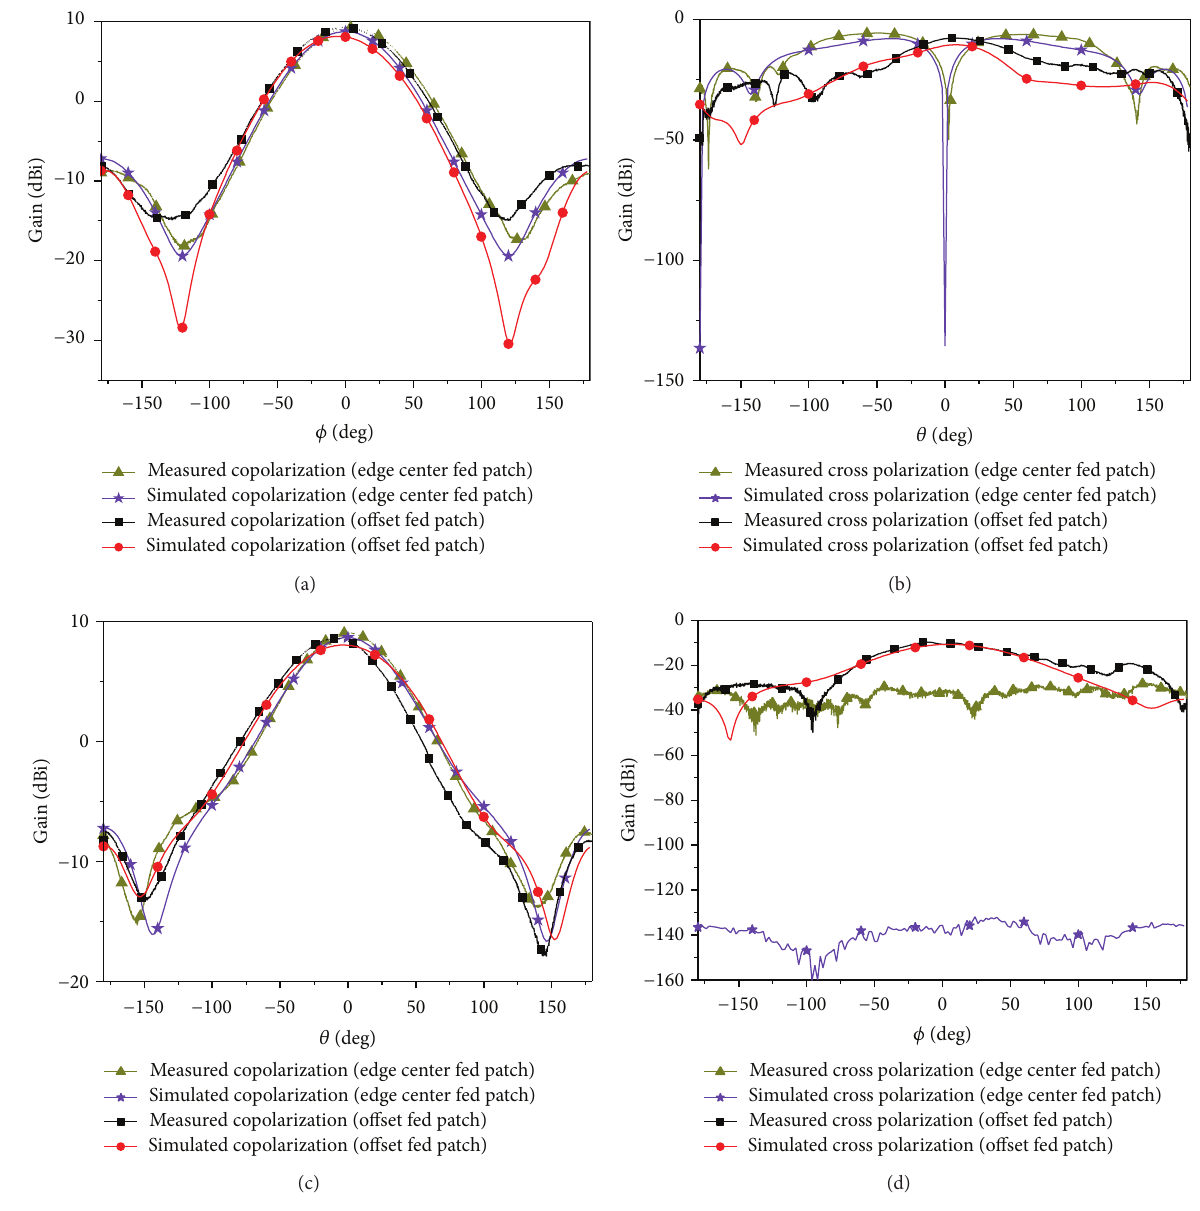
Figure 3: Simulated and measured radiation patterns of the edge center fed antenna ( 𝑓 = 4.319 GHz) and offset fed antenna ( 𝑓 = 4.163 GHz): (a) copolar and (b) cross-polar in the xoz -plane (H-plane) and (c) copolar and (d) cross-polar in the yoz -plane (E-plane).